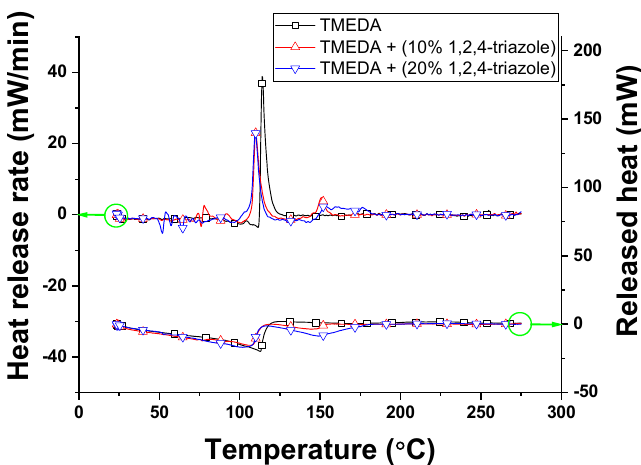
Figure 5. Temporal change of heat release rate and total released heat.